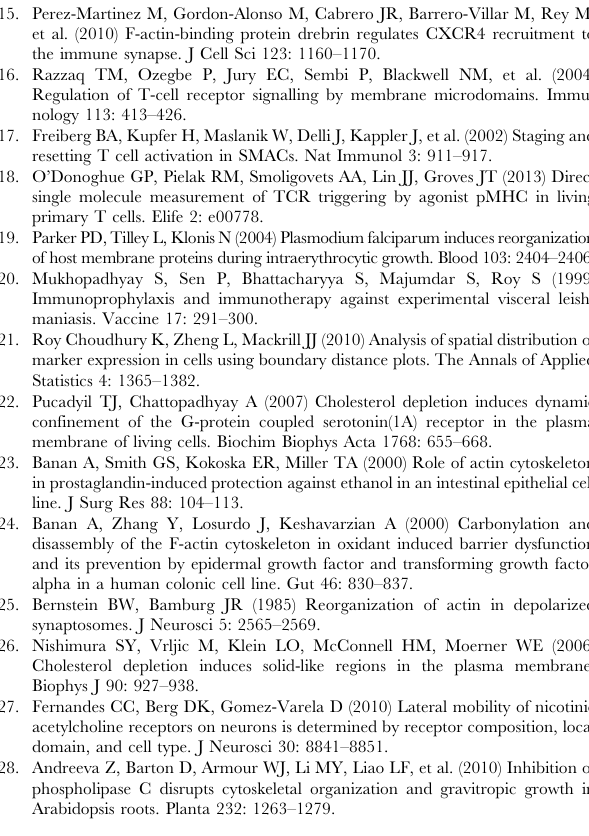
Figure S2 Confocal images of plc d 1-gfp transfected A) N-M W and B) I-M W -CL. The expression of PLC d 1-GFP (green) is on the cell surface. The cells were stained with Hoechst 33342 (blue). Figure S3 FRAP of plc d 1-gfp transfected N-M W . A) The bleach of PLC d 1-GFP (green) on the cell surface. B) The bleach of